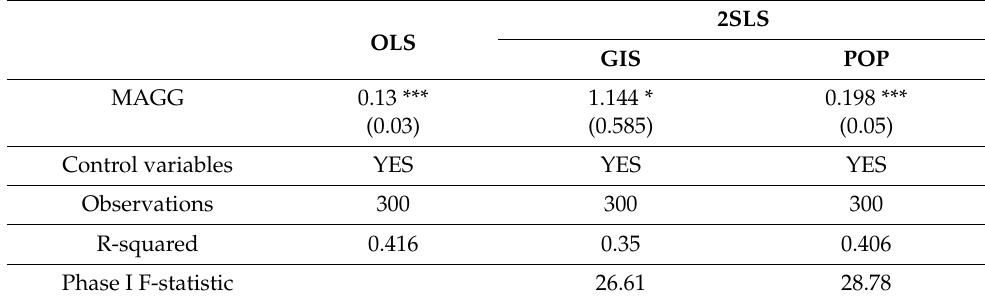
Table 5. OLS and 2SLS estimation